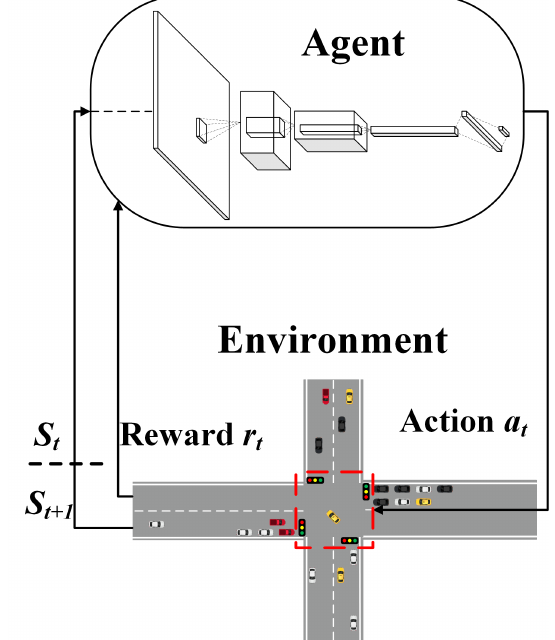
Figure 2. The traffic signal controller based on DRL. There is the traffic signal control system referred as agent in the red-dashed